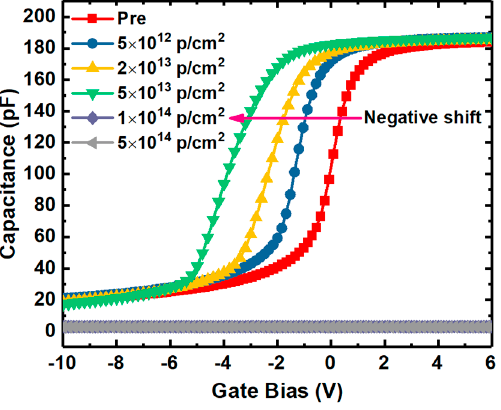
Figure 3. High frequency (HF) C-V characteristics of the samples irradiated by proton doses.